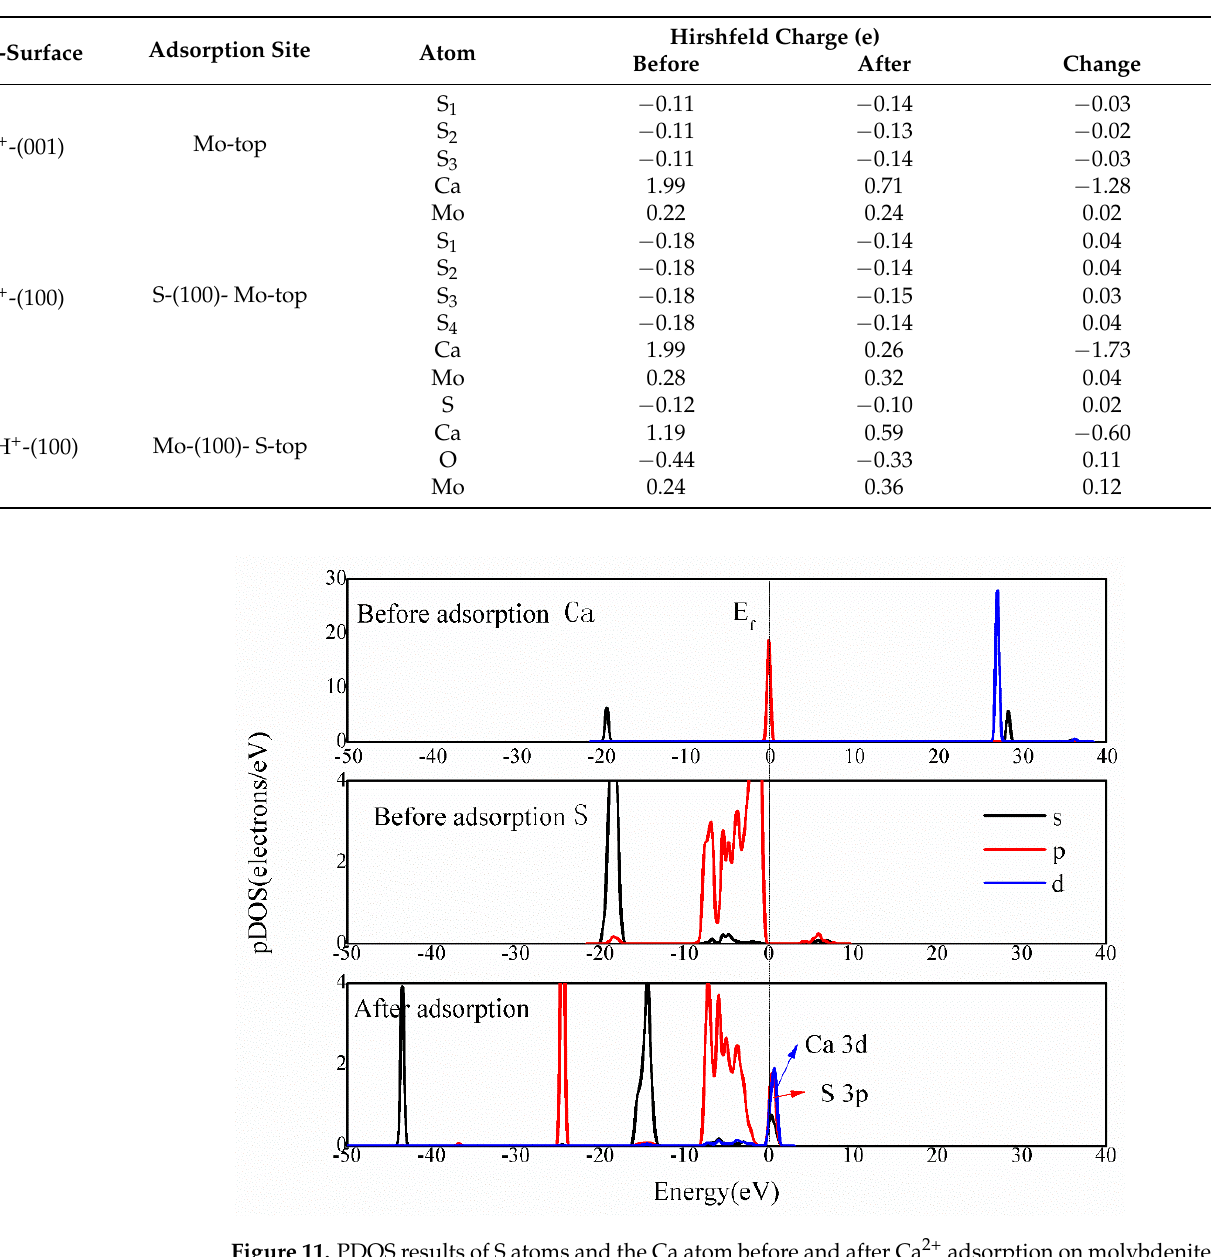
Table 5. Hirshfeld charge of atoms before and after adsorption.